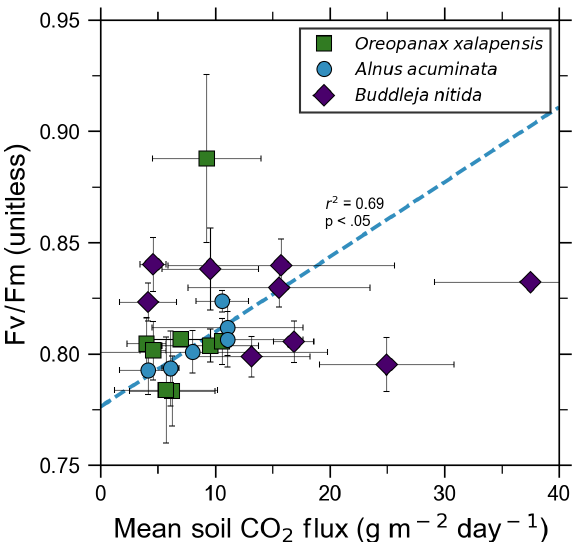
Figure 6. Some tree species in old-growth forests on the upper flanks of two active volcanoes in Costa Rica, Turrialba and Irazú, may express their short-term response to volcanically elevated CO 2 by producing more chlorophyll. A species that showed strong short- term response ( A. Acuminata ; Fig. 5) also shows a positive correla- tion between chlorophyll concentration and mean soil CO 2 flux.